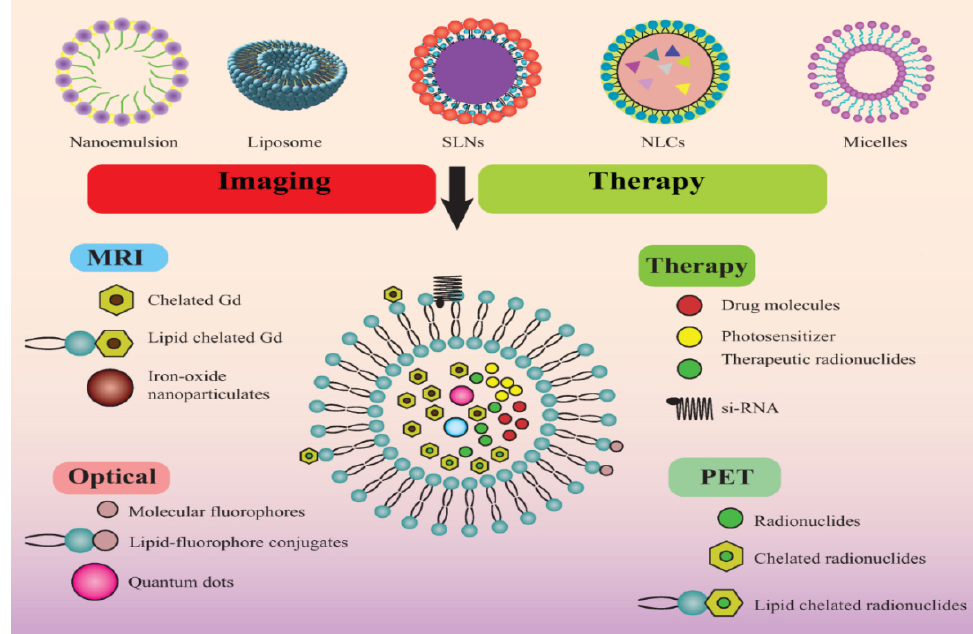
Figure 4. Different types of lipid nanoparticles viz. nanoemulsion, liposome, solid lipid nanoparticle (SLN), nanostructured lipid carrier (NLC), and micelles with significant utility in cancer imaging and therapy.